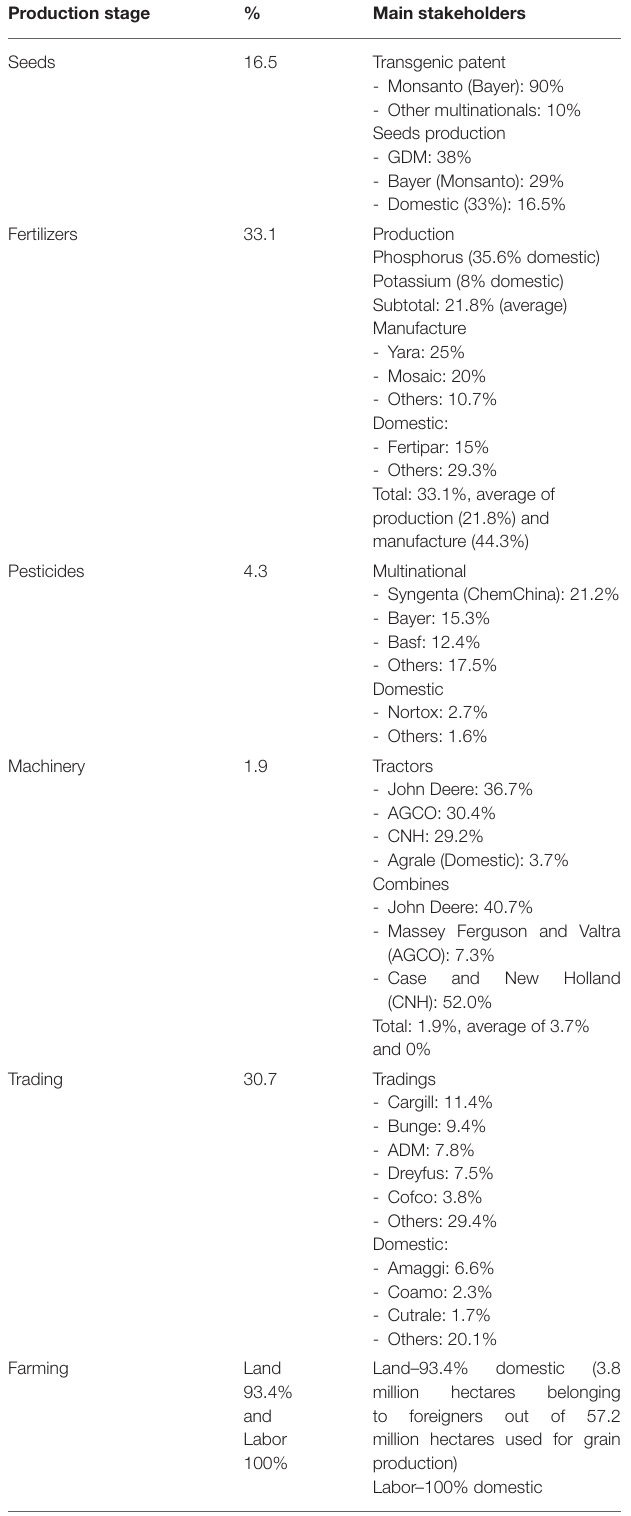
TABLE 1 | Market share hold by domestic groups in the main production stages of the soybeans production chain in Brazil for the agricultural year of 2018/2019. Production stage % Main stakeholders